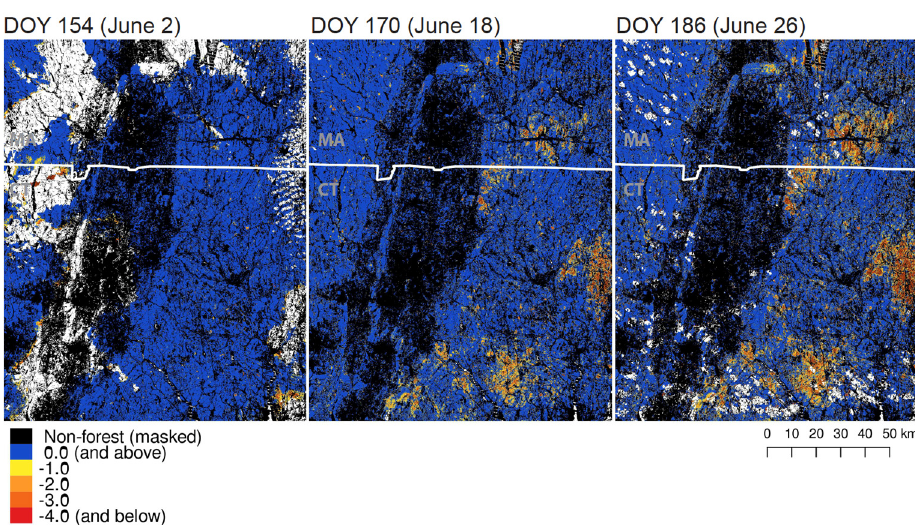
Figure 3. Examples of near-real-time condition assessments for the area around the Connecticut River Valley in 2016. White areas represent no data due to clouds and cloud shadows. Though each individual assessment may be subject to data loss, changes in condition that are not present in the 2 June image clearly manifest in the 18 June image and persist in the 26 June image. Thus, individual assessments can be considered for rapid response, while use of the temporal domain provides increased certainty that the observed patterns are due to defoliator activity.